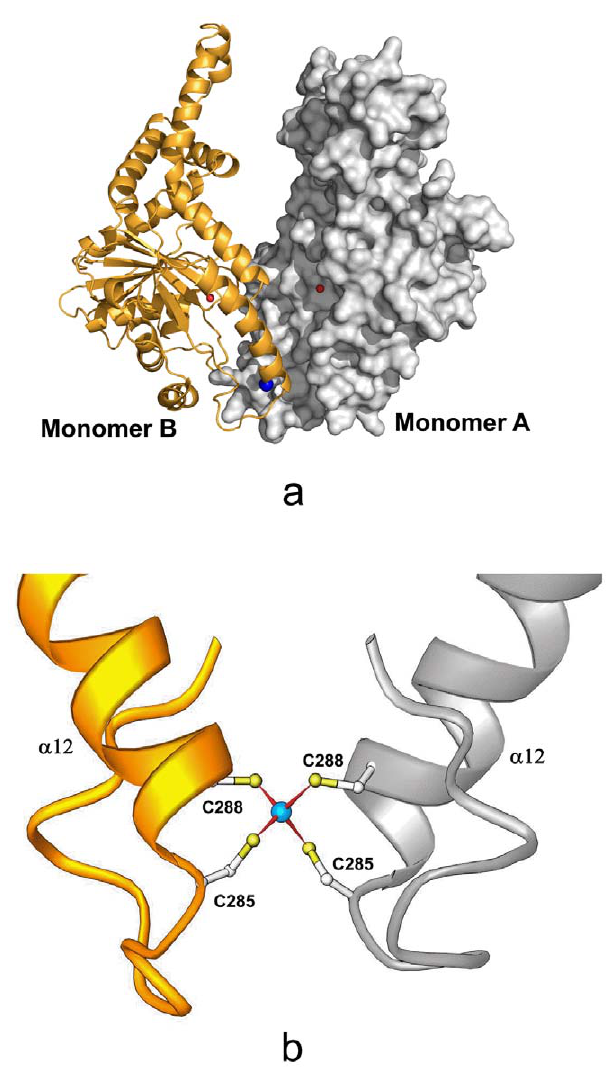
Figure 2. Dimerization of S.cerevisia Get3 molecule. a) The Get3 dimer illustrated by PYMOL. The molecular surface of the Monomer A is shown in silver and Ribbons drawing of the monomer B is shown in gold. The orientation of this Get3 dimer is about 180 u rotation along the vertical axis from that in Fig. 1. The dimer interface is located at the bottom of the structure. The Zinc ion is shown in a blue sphere and the two Mg ions at the nucleotide-binding sites are shown in red spheres. b) The inter- molecular Zinc-finger motif. The Zinc ion is bound by C285 and C288 from the N-terminal endofhelix A12from monomer A and B, respectively. C285, C288 and a 12 are labeled. The Zn ion is shown in a blue